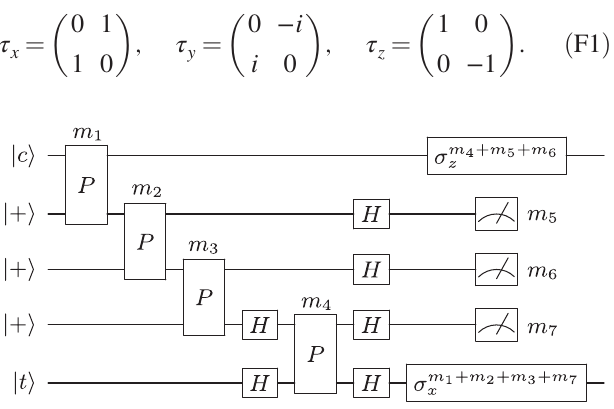
FIG. 22. Quantum circuit corresponding to the constant-time overhead CNOT gate in Fig.